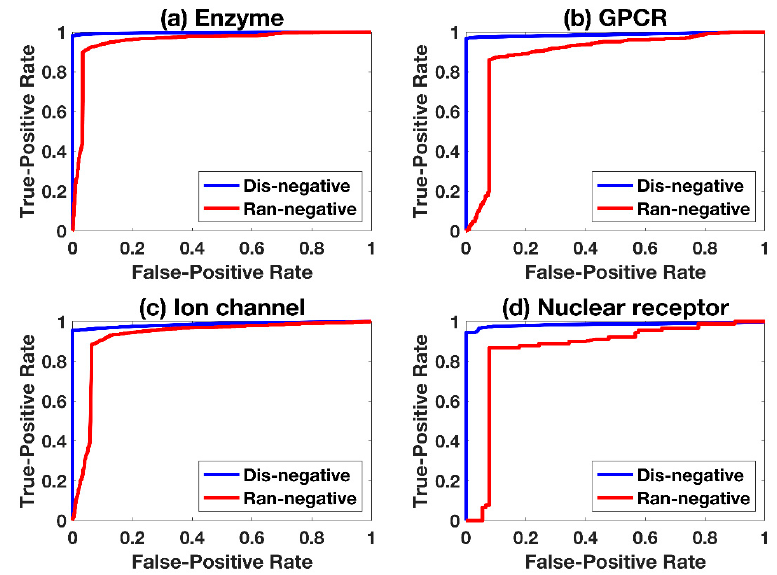
Figure 4. ROC-curves of two negative sampling methods. Ran-negative and Dis-negative represent the setting of negative sampling based on random and distance, respectively.